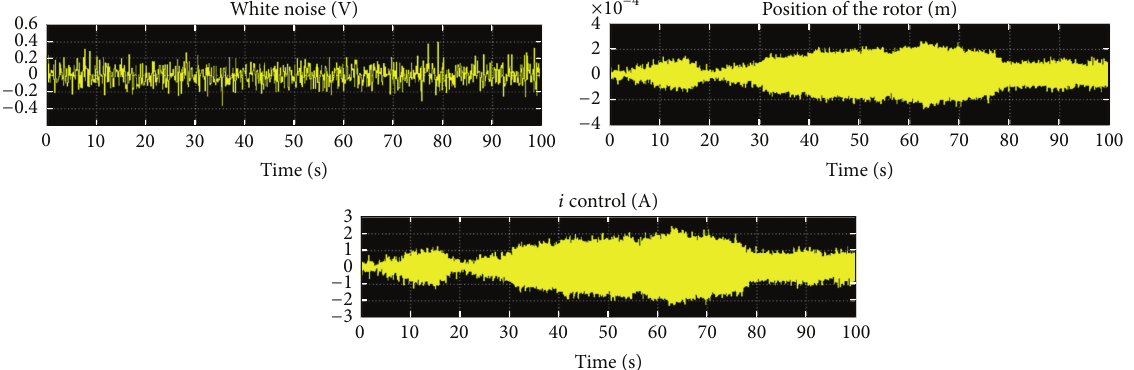
Figure 5: System response with P controller with proportional gain of 8875.1 and white noise of 0.001